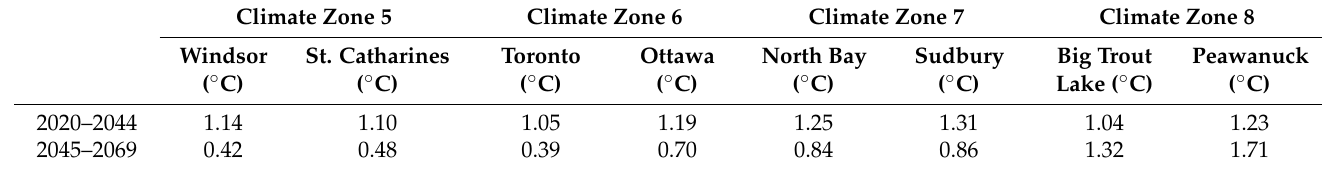
Table 6. Annual temperature difference between 2020 and 2044 and 2024 and 2069 for the 8 cities. Climate Zone